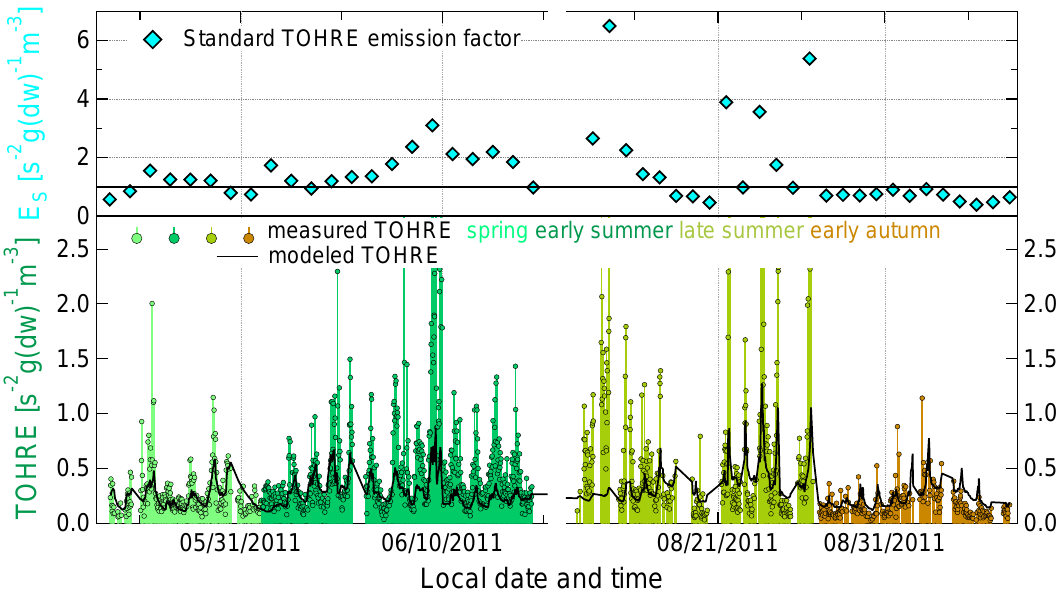
Fig. 8. Overview for model, calculation and measurement comparison of TOHRE: the entire campaign has been modeled (black line) using an unscaled temperature-only-dependent algorithm to compare to measured TOHRE (markers on sticks). Superimposed is the daily standard total OH reactivity emission factor.